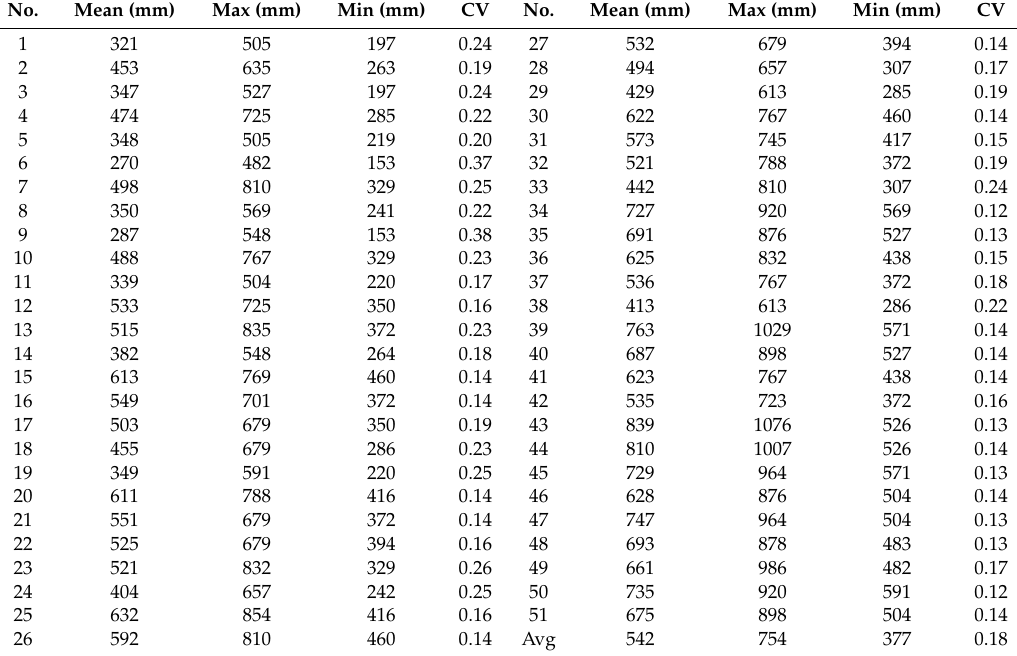
Table 2. The mean, extremes and CV of the selected 51 AP series